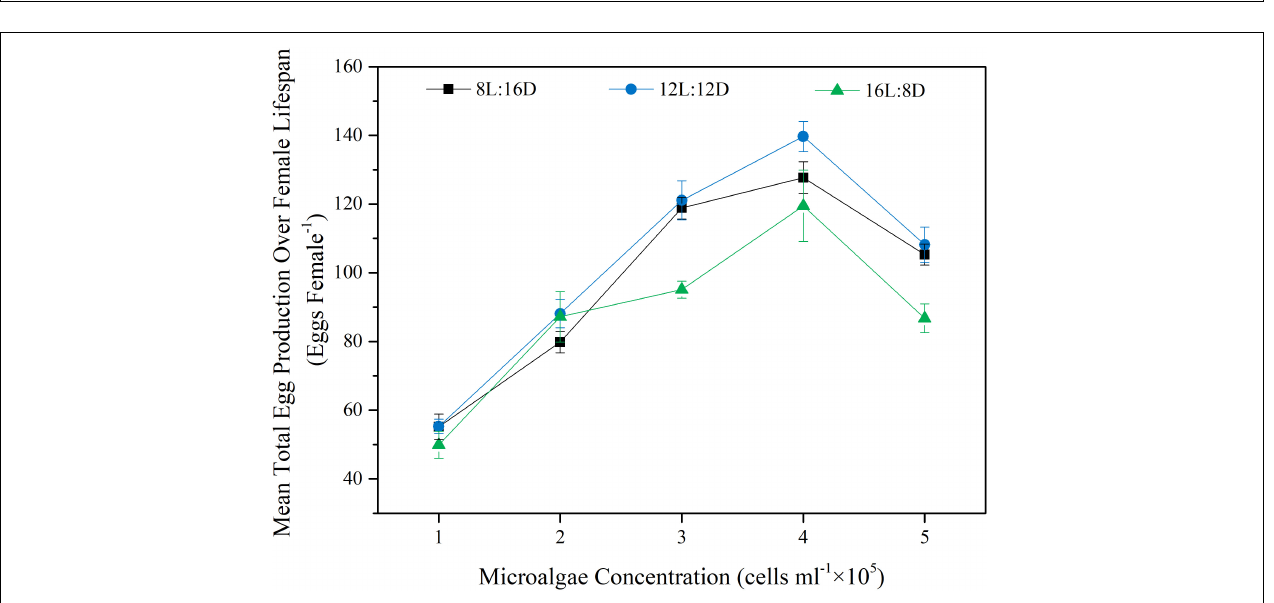
FIGURE 2 | Effects of different concentrations of the microalgal diet and photoperiods on total egg production over female lifespan of B. amoyensis ( N = 12). Data is presented as mean ± SE.